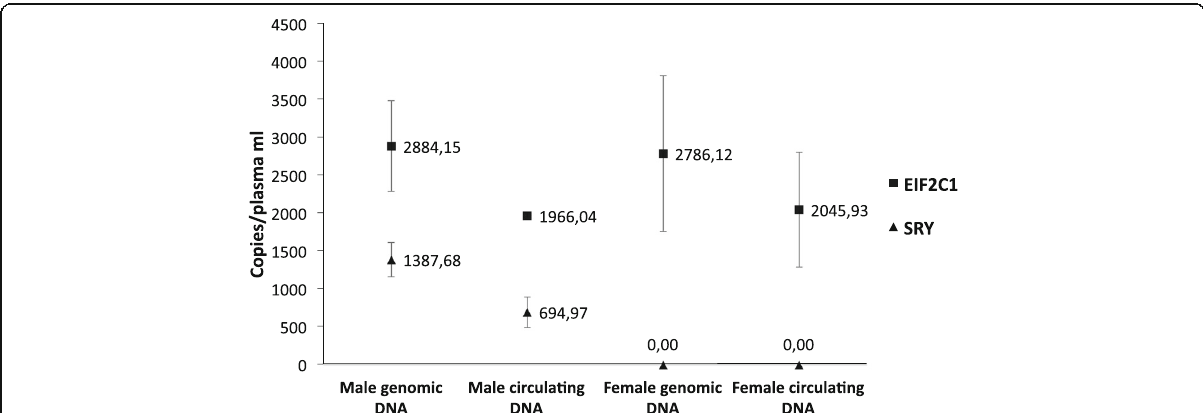
Fig. 2 ddPCR analysis on male and female circulating and genomic DNA samples in order to set-up the SRY assay. The concentration average (from three different subjects for each category) of SRY (dots) and EIF2C1 (squares) was expressed in copies/ μ L of reaction, obtained through QuantaSoft software, based on Poisson ’ s statistics